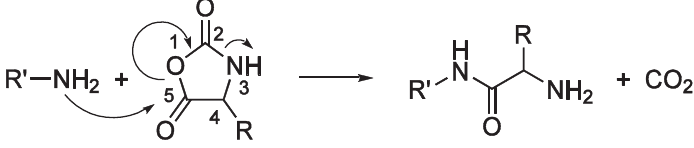
Figure 47. Mechanism of CO Leuchs anhydride.